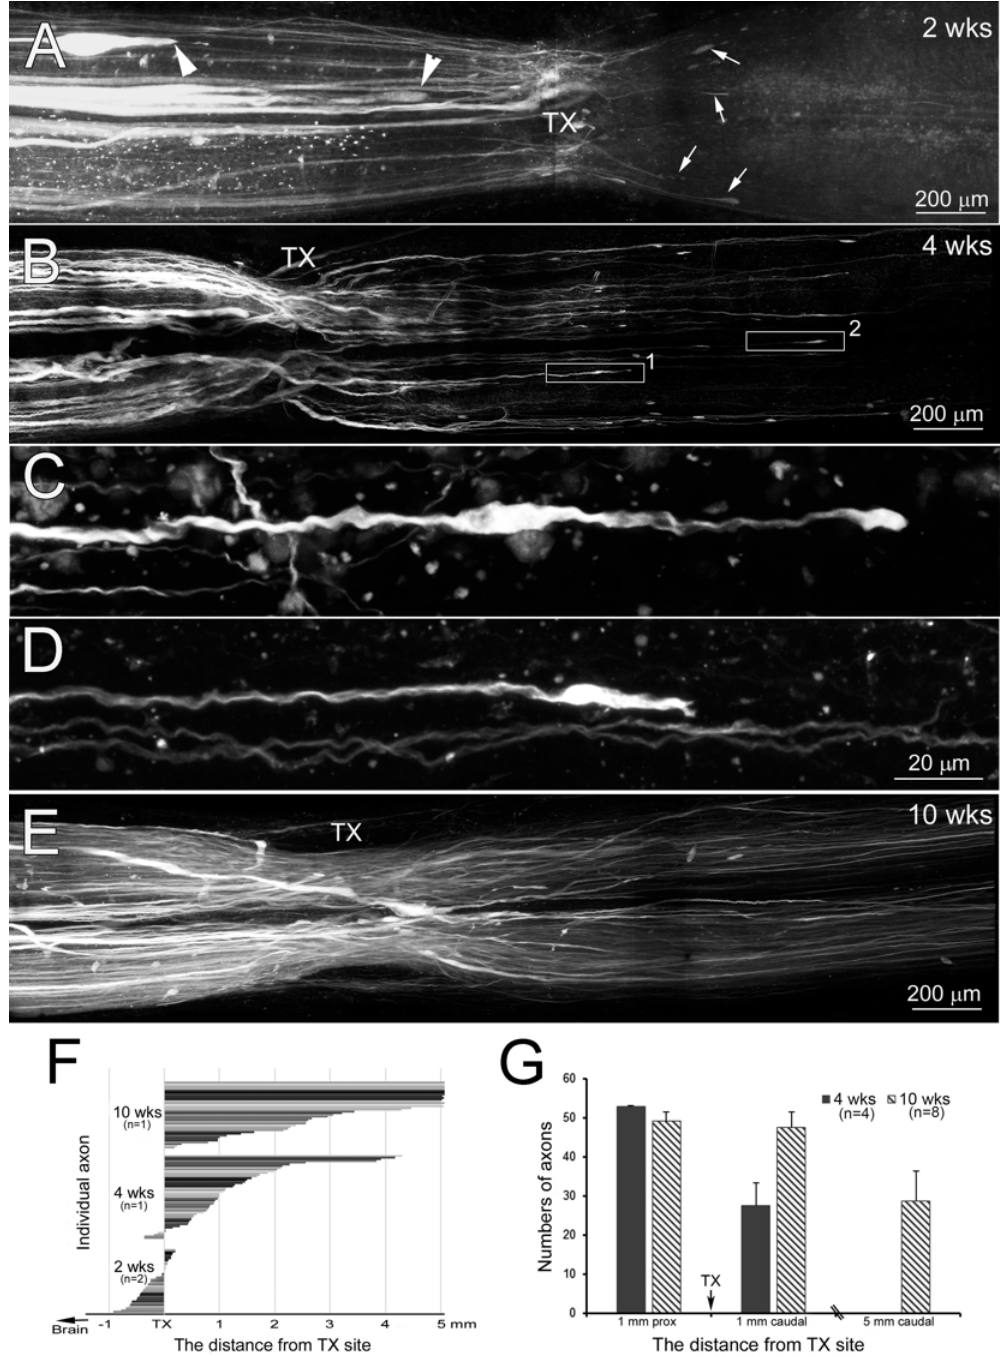
Figure 10. Regenerating axons demonstrated by anterograde labeling and BABB clearing. ( A , B , E ) maxium intensity projection confocal images of SC spanning the TX site at different recovery times, as indicated. ( A ) some axons have regenerated through lesion into the caudal stump (arrows) as early as 2 weeks post-TX. ( C , D ) enlarged images of bulbous axon tips from white boxes 1 and 2 in ( B ), respectively. ( F ) the distance of axon tips to / from the TX site. Each bar represents an individual axon. ( G ) counts of axons from maximum intensity projection confocal images at different distances from the TX, as indicated.